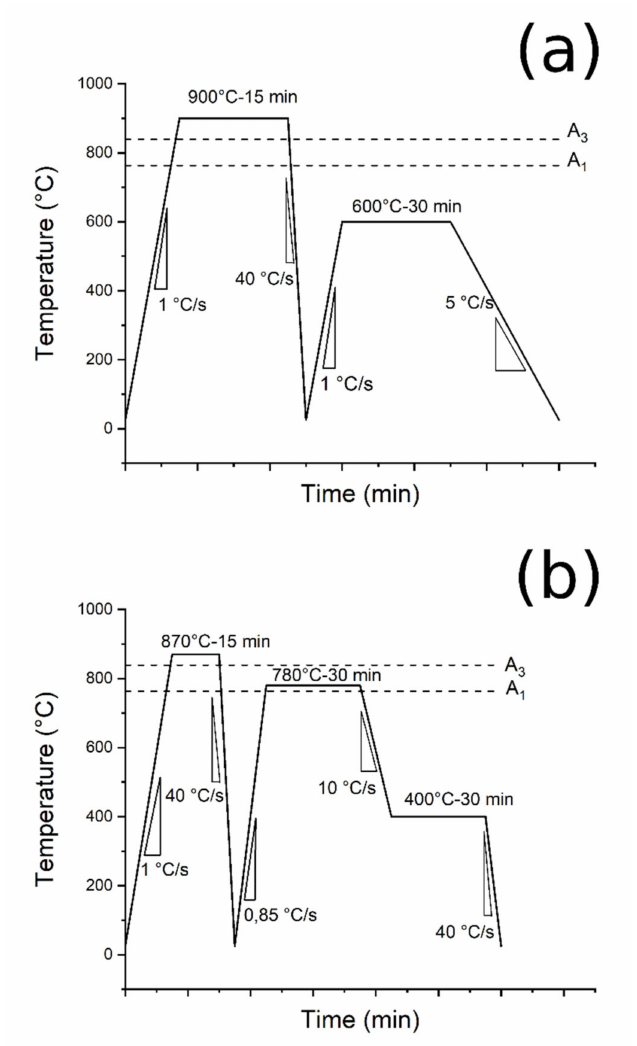
Figure 3. Heat treatment processing scheduled for the high silicon steel: ( a ) Quenching and Partitioning (Q&P), ( b )